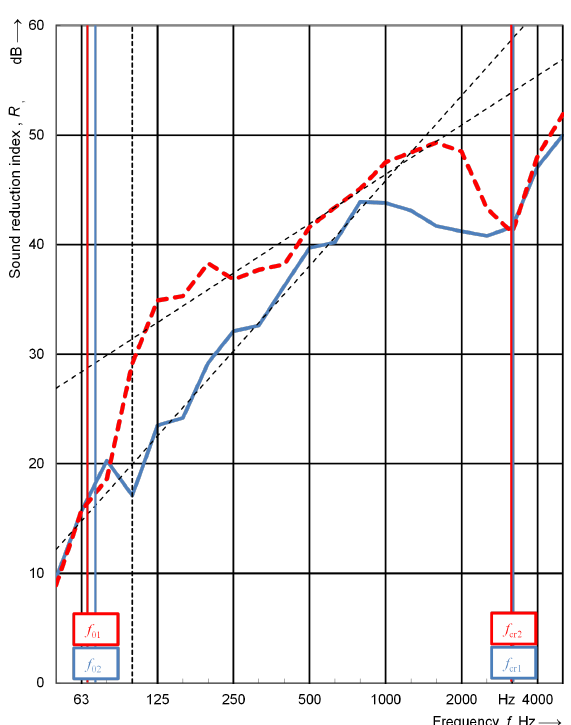
Figure 9. Sound reduction index of basic element: wood fibre – the solid blue curve, mineral wool – the dashed red curve.